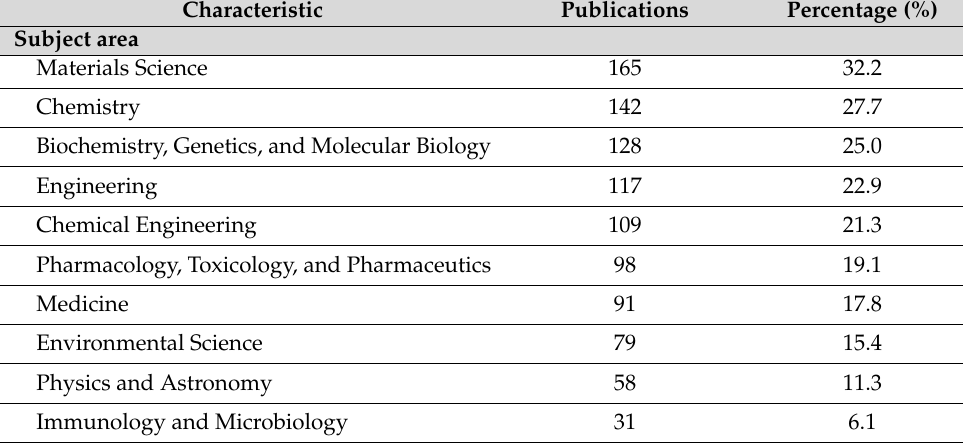
Table 1. Top 10 subject areas and journals of the polymer research related to COVID-19.